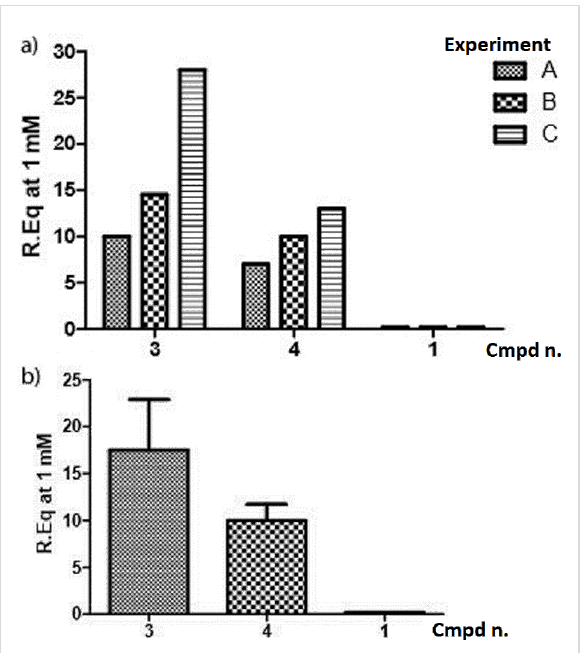
Figure 4: a) Relative affinities of glycocalixarene 1 , 3 , 4 (1 mM) towards Gal-3, expressed in terms of the increase of the resonance unit (RU) in three independent (A, B, C) SPR experiments. b) average affinities of glycocalixarenes with standard